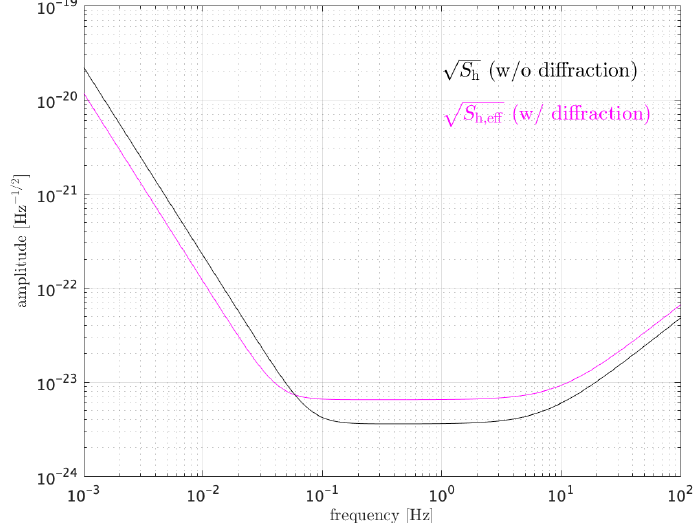
Figure 5. Sensitivity curves in terms of the square root of the PSD without the diffraction loss (black) and the one including the effect of the diffraction (magenta). Each parameter in the calculation is shown in Table